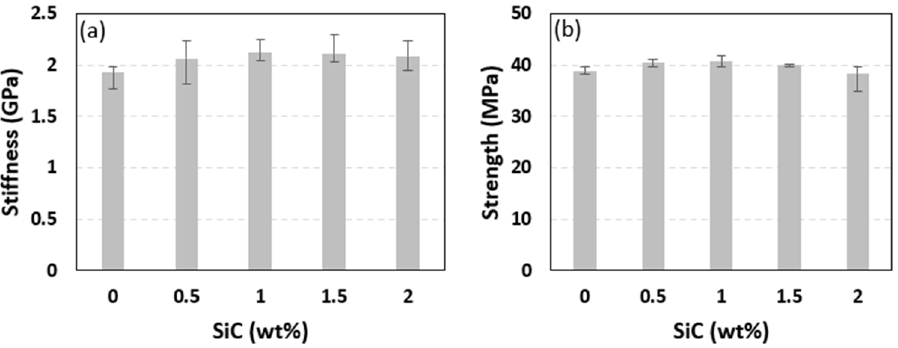
Figure 14. Effect of SiC weight fraction on PLA-SiC reinforced filaments’ stiffness ( a ) and tensile strength ( b ).